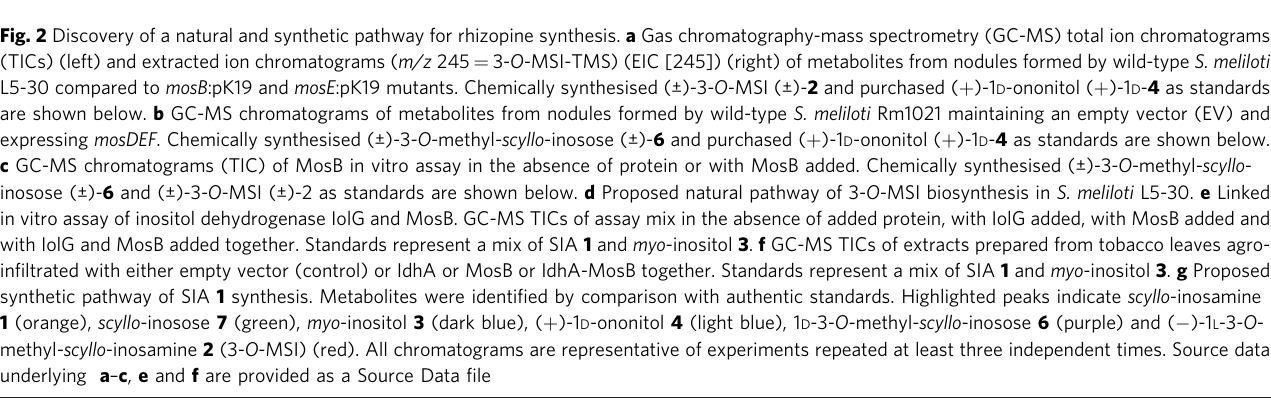
Fig. 2 Discovery of a natural and synthetic pathway for rhizopine synthesis. a Gas chromatography-mass spectrometry (GC-MS) total ion chromatograms (TICs) (left) and extracted ion chromatograms ( m/z 245 = 3- O -MSI-TMS) (EIC [245]) (right) of metabolites from nodules formed by wild-type S. meliloti L5-30 compared to mosB :pK19 and mosE :pK19 mutants. Chemically synthesised (±)-3- O -MSI (±)- 2 and purchased ( + )-1 D -ononitol ( + )-1 D - 4 as standards are shown below. b GC-MS chromatograms of metabolites from nodules formed by wild-type S. meliloti Rm1021 maintaining an empty vector (EV) and expressing mosDEF . Chemically synthesised (±)-3- O- methyl- scyllo -inosose (±)- 6 and purchased ( + )-1 D -ononitol ( + )-1 D - 4 as standards are shown below. c GC-MS chromatograms (TIC) of MosB in vitro assay in the absence of protein or with MosB added. Chemically synthesised (±)-3- O- methyl- scyllo - inosose (±)- 6 and (±)-3- O -MSI (±)-2 as standards are shown below. d Proposed natural pathway of 3- O- MSI biosynthesis in S. meliloti L5-30. e Linked in vitro assay of inositol dehydrogenase IolG and MosB. GC-MS TICs of assay mix in the absence of added protein, with IolG added, with MosB added and with IolG and MosB added together. Standards represent a mix of SIA 1 and myo -inositol 3 . f GC-MS TICs of extracts prepared from tobacco leaves agro- in fi ltrated with either empty vector (control) or IdhA or MosB or IdhA-MosB together. Standards represent a mix of SIA 1 and myo -inositol 3 . g Proposed synthetic pathway of SIA 1 synthesis. Metabolites were identi fi ed by comparison with authentic standards. Highlighted peaks indicate scyllo -inosamine 1 (orange), scyllo -inosose 7 (green), myo -inositol 3 (dark blue), ( + )-1 D -ononitol 4 (light blue), 1 D -3- O -methyl- scyllo -inosose 6 (purple) and ( − )-1 L -3- O - methyl- scyllo -inosamine 2 (3- O -MSI) (red). All chromatograms are representative of experiments repeated at least three independent times. Source